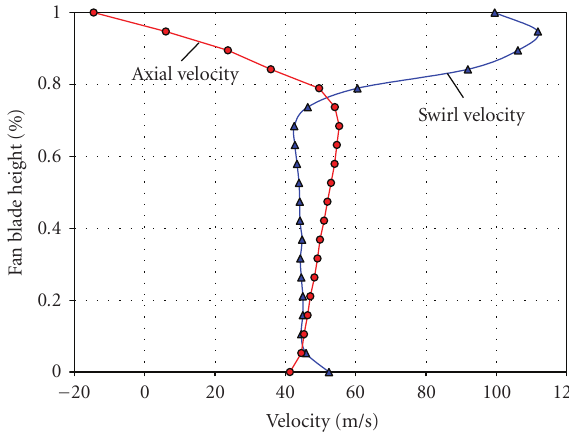
Figure 13: Velocity distributions alnog the fan blade